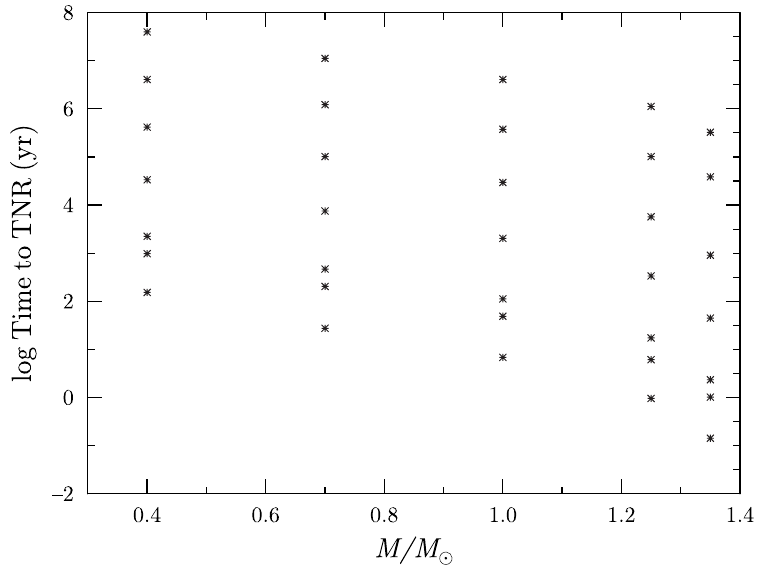
Fig. 3. The log of the accretion time to the TNR as a function of WD mass. Each of the data points is for a different ˙ M and the value of ˙ M increases downward for each WD mass. The accretion time, for a given ˙ M decreases with WD mass because it takes less mass to initiate the TNR as the WD mass increases.